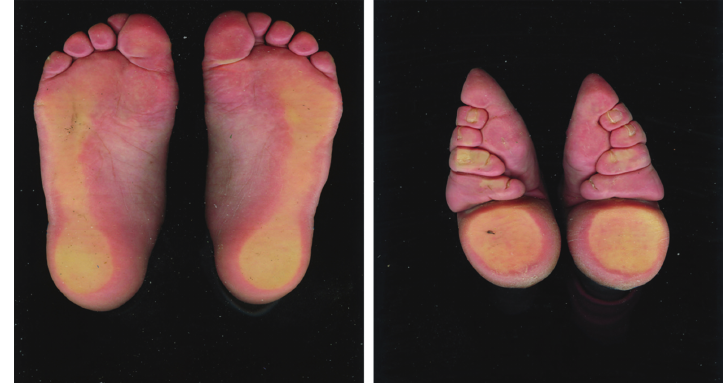
Figure 2: Comparison of pelma print scanning picture between the foot-binding deformity and normal